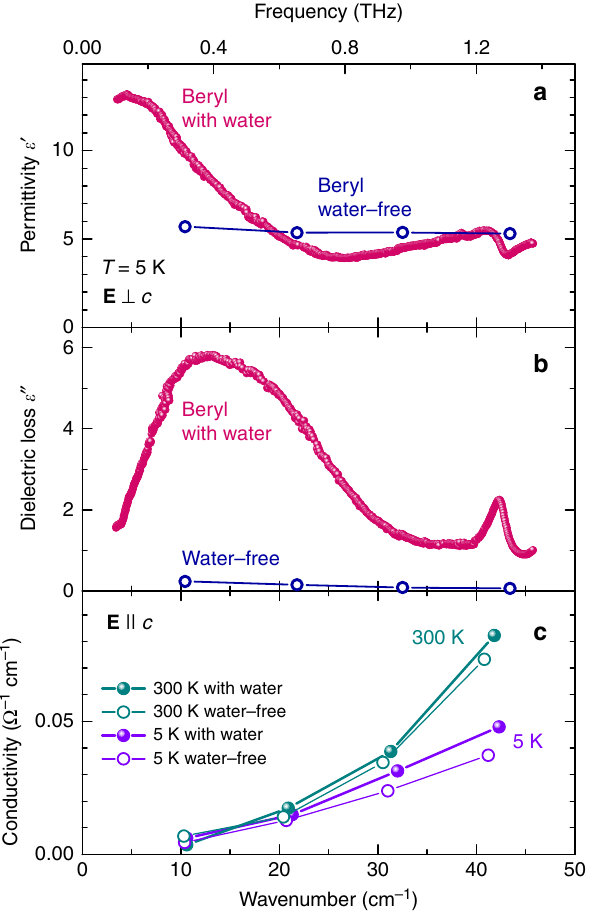
Figure 4 | Terahertz spectra of hydrated and water-free beryl single crystals. ( a , b ) Spectra of the real and imaginary parts of the dielectric permittivity measured in the polarization E > c at low temperatures, T ¼ 5K. ( c ) Spectra of the optical conductivity of hydrated (cyan) and water-free (violet) crystals measured at T ¼ 300 and 5K for the polarization E || c .